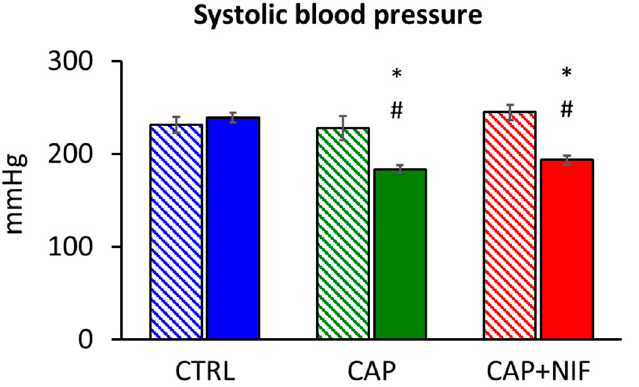
Figure 1. Systolic blood pressure of old SHR expressed as mean ± SEM at baseline (60 weeks of age; hatched columns) and at the final measurement after 22 weeks of experiment (82 weeks of age; filled columns). Significance marks: # significant vs. baseline measurement ( p < 0.001); * significant vs. CTRL ( p < 0.001).